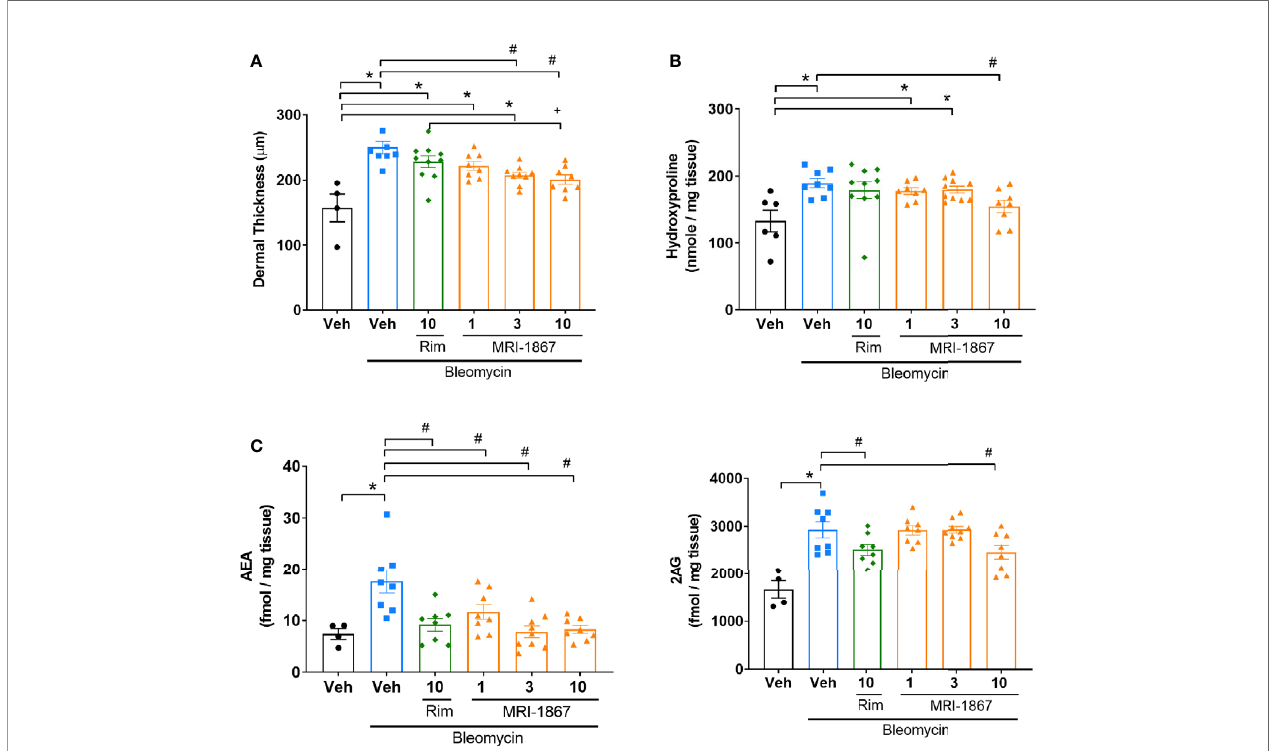
FIGURE 5 | Comparison of the anti- fi brotic effects of MRI-1867 and rimonabant in Mdr1 ( − = − ) -Bcrp (-/-) mice. (A) Dermal thickness analysis, (B) Hydroxyproline levels, a = b (C) AEA and 2AG levels from skin biopsies in control and bleomycin-injected Mdr1a/b(-/-) -Bcrp (-/-) mice. Rimonabant (10 mg/kg) or MRI-1867 (1, 3, 10 mg/kg) were orally administered daily for the last 14 days of bleomycin injections. Data represent means ± SEM from 4-10 mice per group. Data were analyzed by 1-way ANOVA followed by Dunnett ’ s multiple comparisons test. Signi fi cant difference from corresponding values in control (saline and vehicle treated group) (*P < 0.05), or from values in bleomycin and vehicle-treated group ( # P < 0.05), or from values in bleomycin and rimonabant-treated group ( + P <